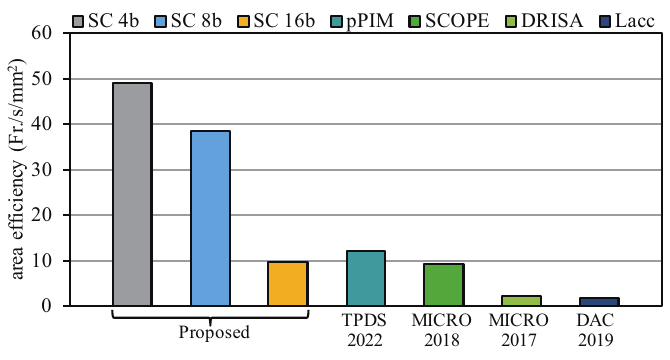
Figure 18. Area efficiency comparison with other works.